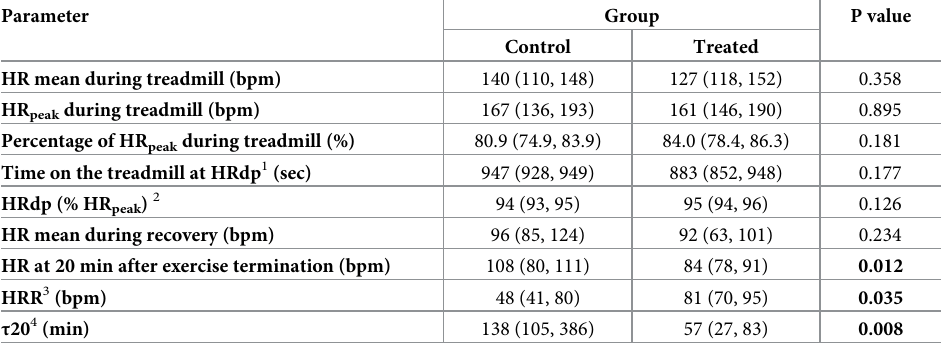
Table 1. Heart rate (HR) mean, deflection point (HRdp), HR at 20 min after exercise termination, heart rate recovery (HRR) and time constants of the post-exercise HR decay ( τ 20) in control and treated groups. The values are medians and interquartile